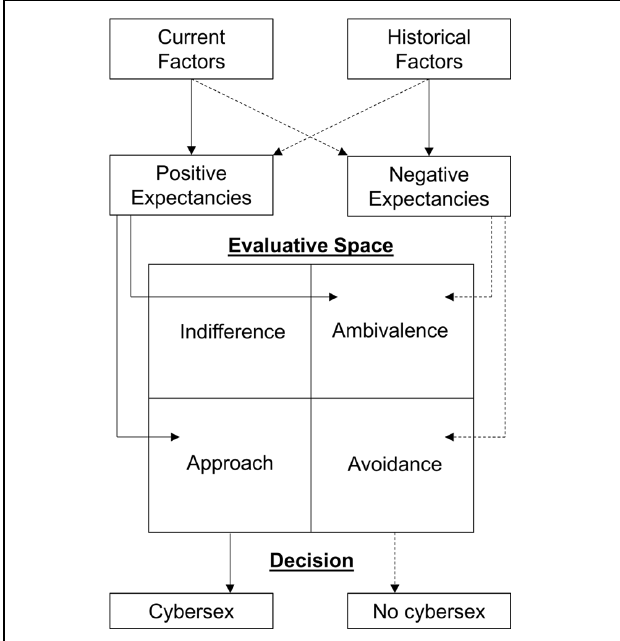
FIGURE 1 | Simplified overview of the approach/avoidance framework by Breiner et al. (1999) adapted to cybersex addiction. Straight lines represent inclinations which may elicit tendencies promoting cybersex use while dashed lines rather embody tendencies to avoid cybersex